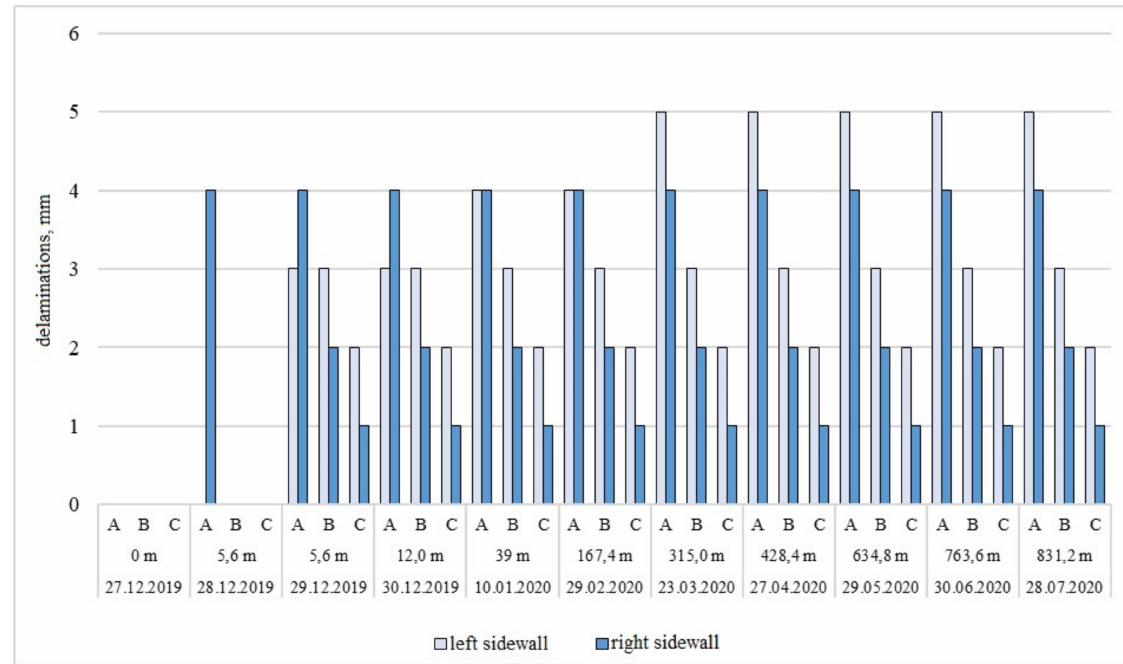
Figure 6. Roof delaminations’ values measured on the periodic control station no.